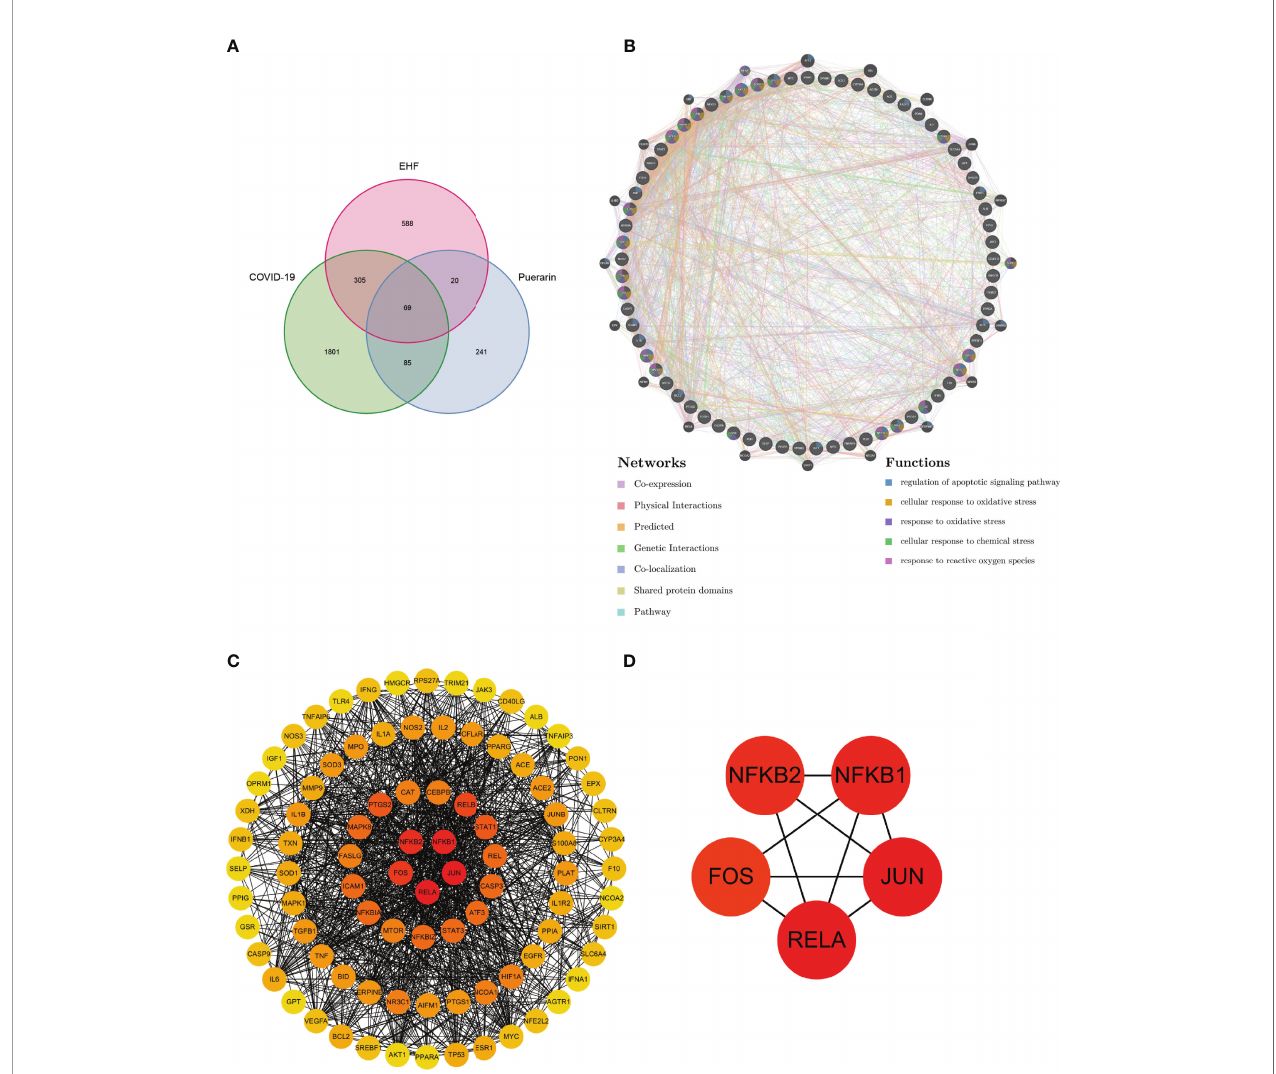
FIGURE 3 | Analysis of common genes for COVID-19, EHF, and puerarin. (A) Venn diagram of the common gene. (B) PPI network of the common gene. (C) Degree value of each node of the PPI network. (D) The top fi ve nodes in the PPI network degree